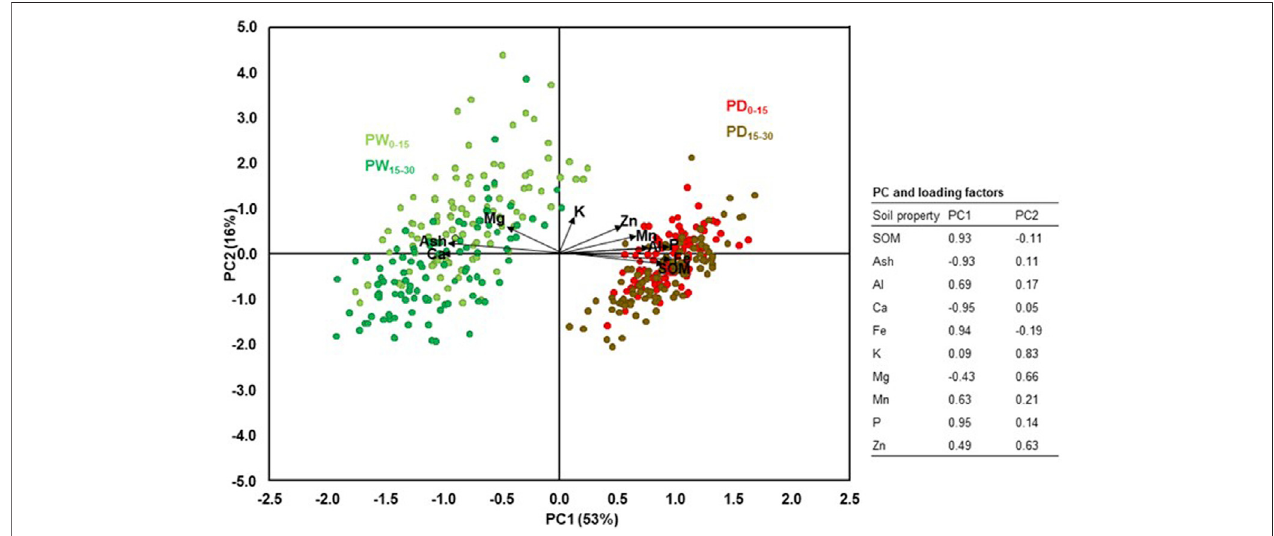
FIGURE 3 | PCA scatter plot of SOM and concentrations of total elements in surface and subsurface horizons of the drained and rewetted peatlands. PD 0-15 : surface horizons of drained peatland, PD 15-30 : subsurface horizons of the drained peatland, PW 0-15 : surface horizons of rewetted peatland, PW 15-30 : subsurface horizons of the rewetted peatland.